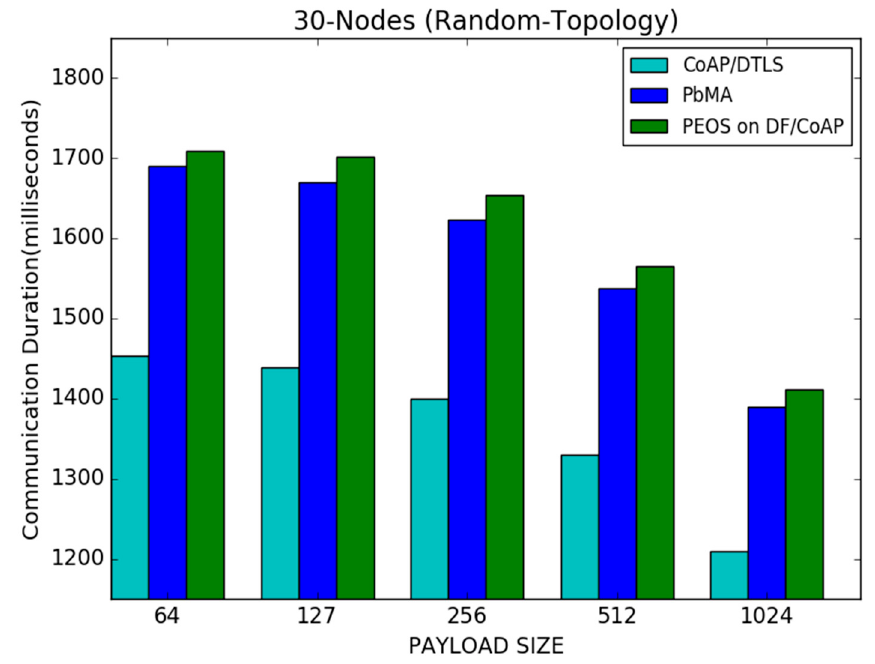
Figure 9. Payload size vs. communication duration for 30 node topology.